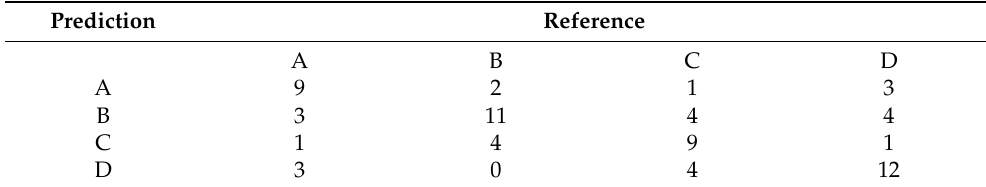
Table 4. Confusion matrix for LDA with the GA selected wave numbers.